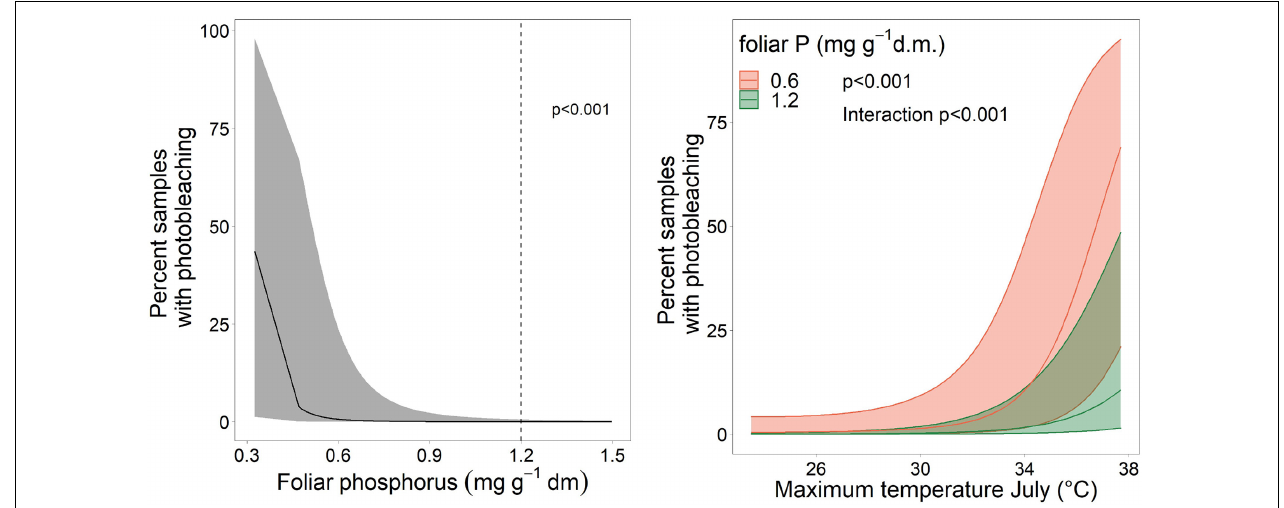
FIGURE 8 | Left : Relation between the proportion of samples with photobleaching and the foliar concentration of P as spline function with two knots. The dotted line gives the lower threshold for normal nutrition according to Göttlein (2016). Right : Illustration of the interaction between maximum July temperature and foliar P concentration on photobleaching. TABLE 2 | Results of a mixed linear regression model of discoloration in the monitoring plots. Est. SE t val. p − 0 . 300